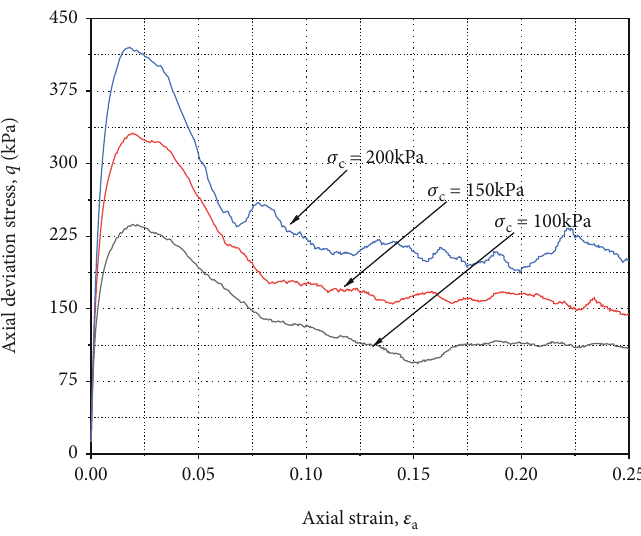
Figure 5: The stress-strain curves of biaxial